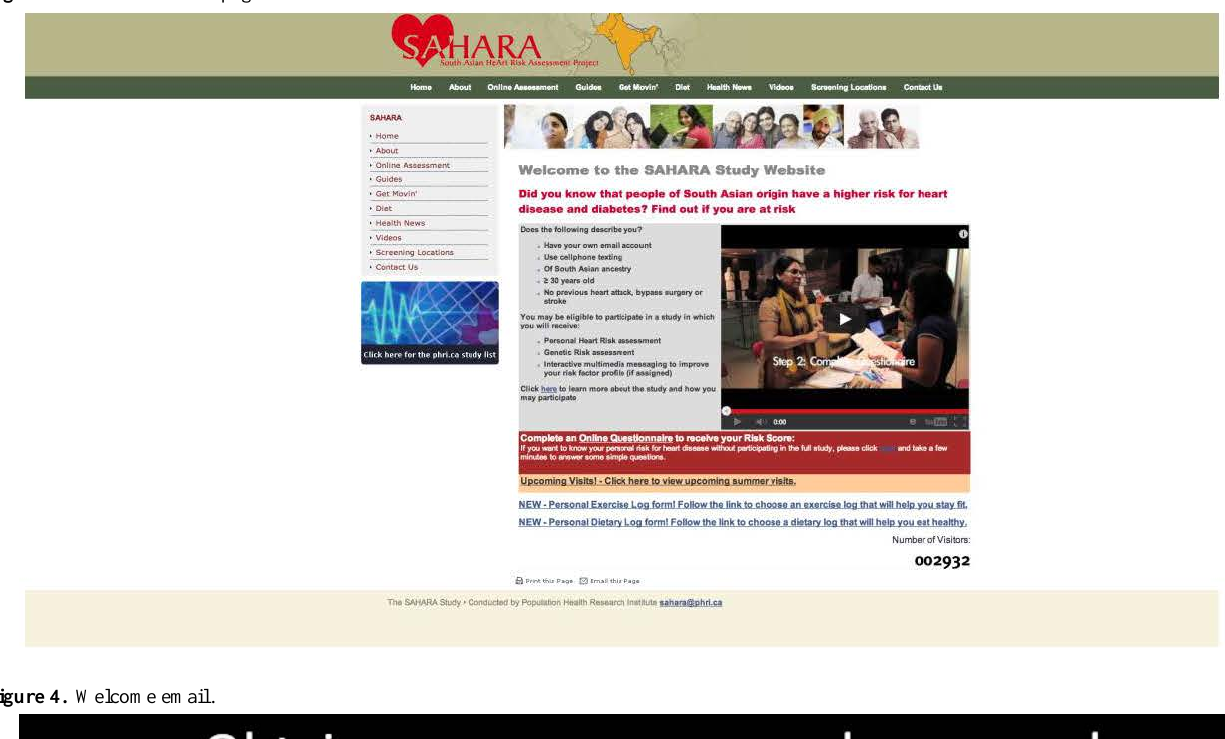
Figure 3. SAHARA home page.